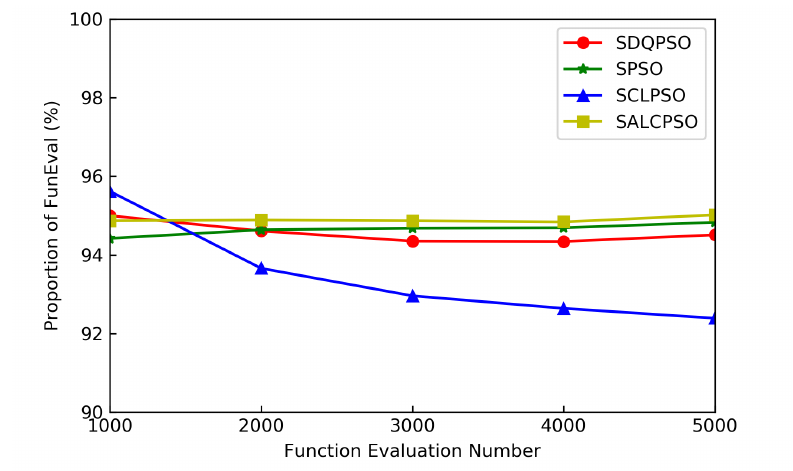
Figure 10. The function evaluation proportion under different function